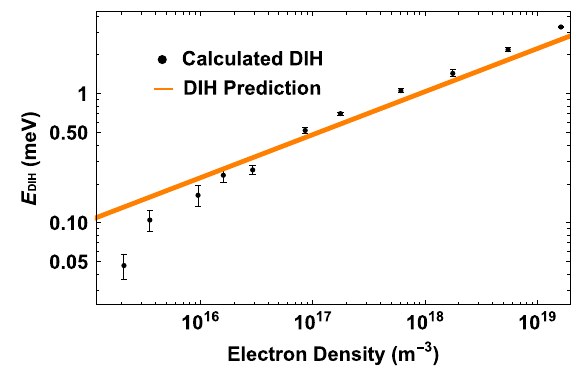
FIG. 13. Disorder-induced heating as calculated from Eq. (2) compared to the result calculated from